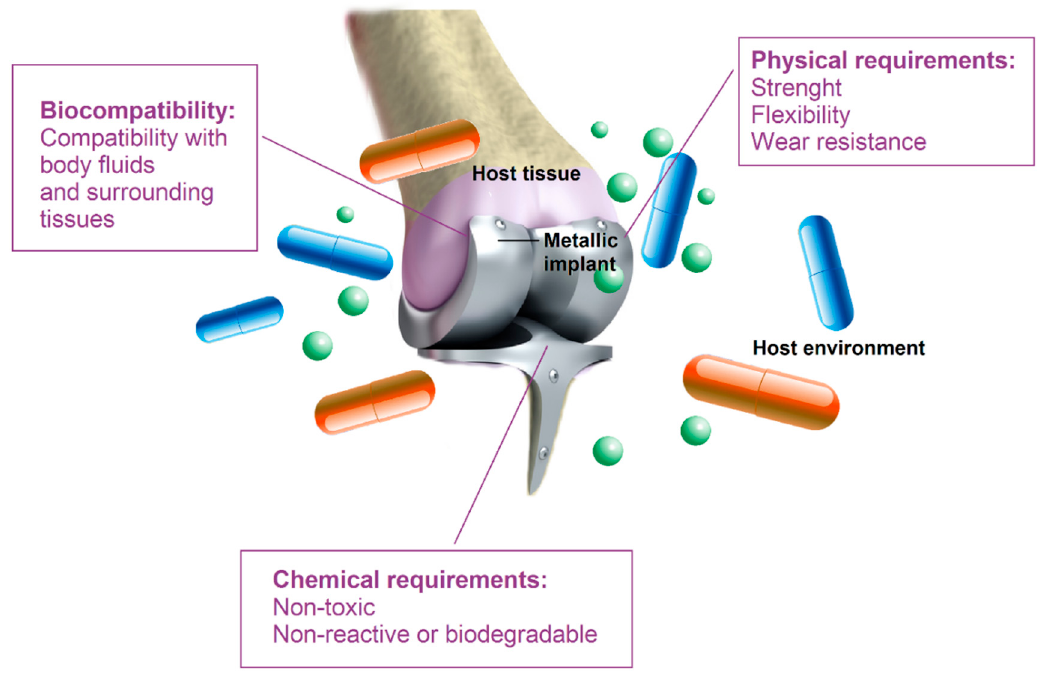
Figure 3. Characteristics of metallic materials regulating the cellular response of an artificial implant reproduced from [47], with permission from Wiley, 2019.